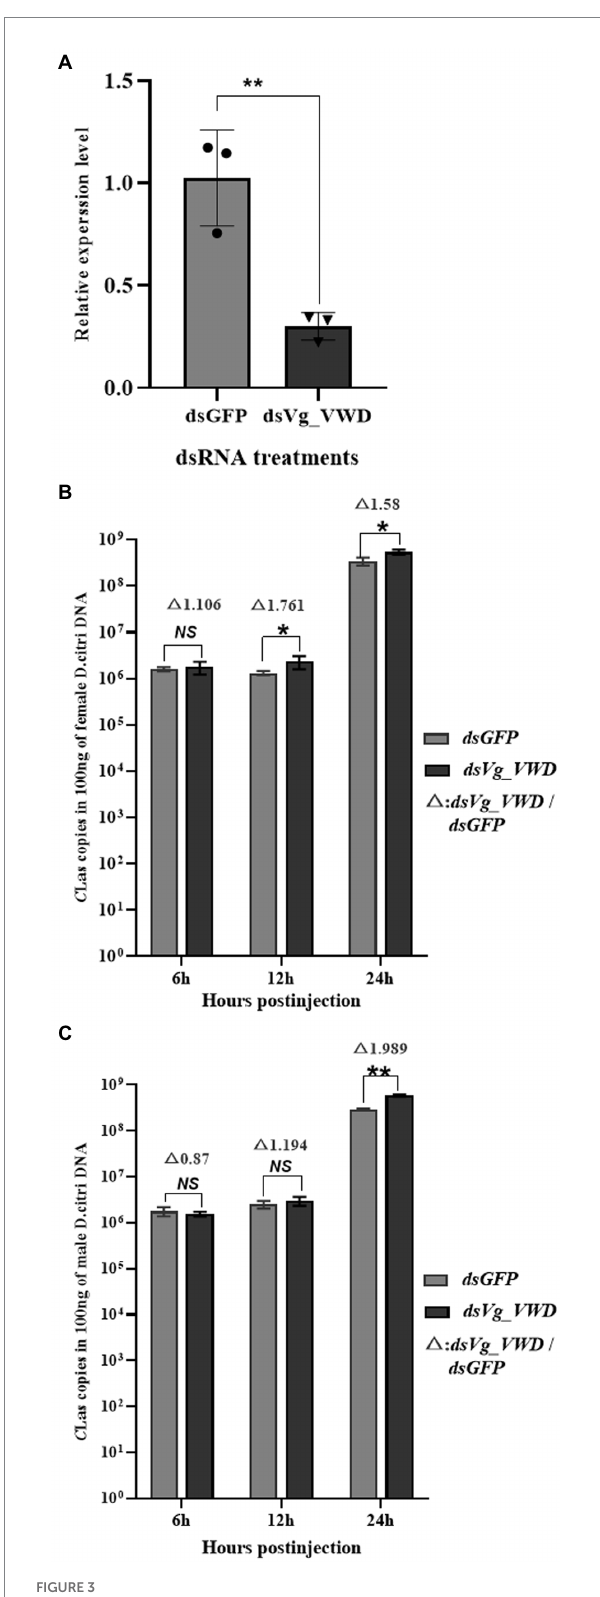
FIGURE 3 D. citri Vg_VWD silencing efficiency and detection of changes in C Las titer after silencing. (A) Vg_VWD silencing efficiency of female D. citri . (B,C) Are the detection of changes in C Las titer at 6, 12, and 24 h after the silencing, respectively. Data analysis was performed using SPSS software for independent samples t -test, the significant differences are indicated by * ( p < 0.05) or ** ( p <